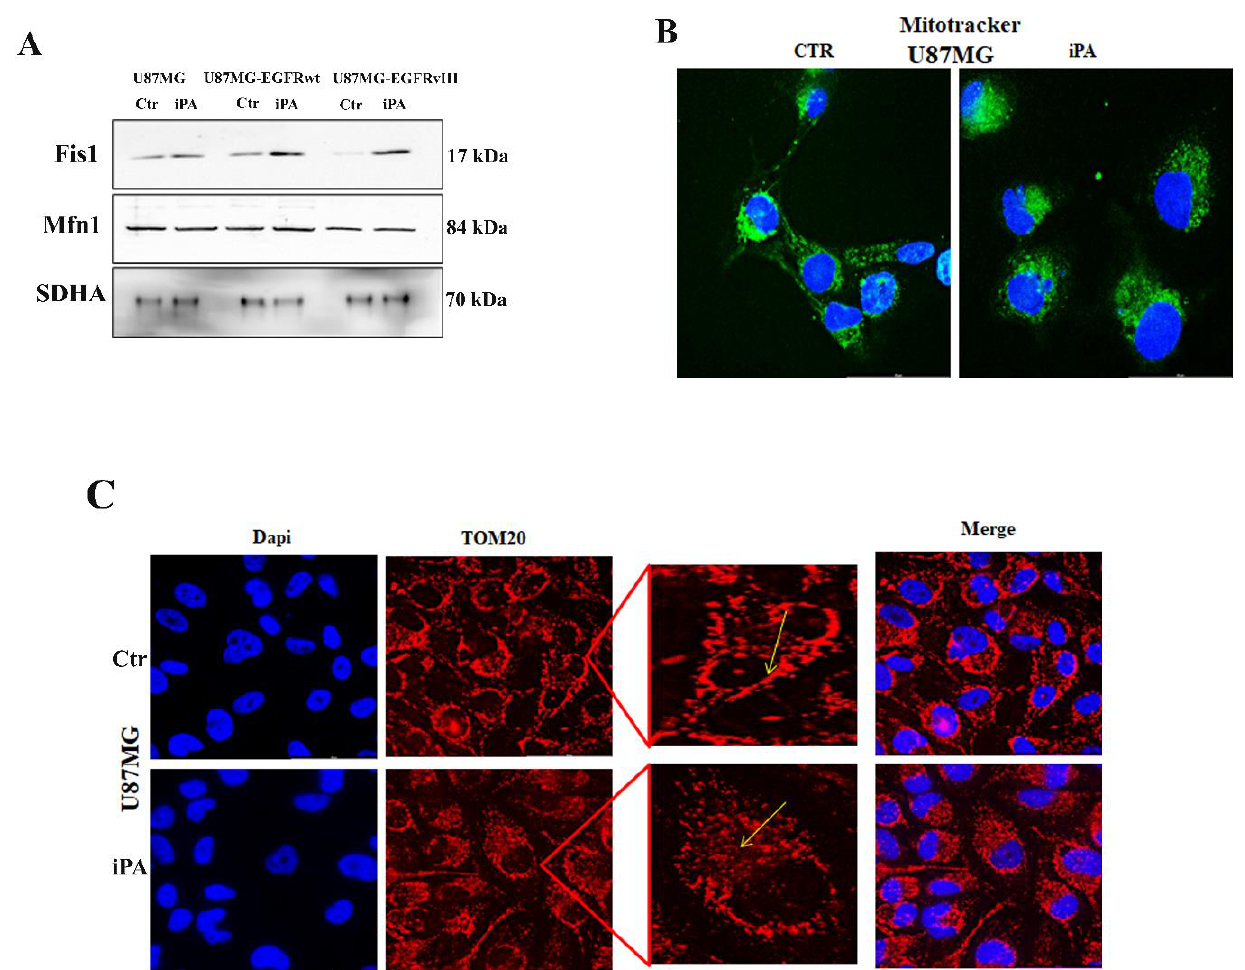
Figure 6. iPA interferes with mitochondrial dynamics. ( A ) Western blot of Fis1 and Mfn1 in U87MG, U87MG-EGFRwt, U87MG-EGFRvIII. ( B ) Mitochondria staining in U87MG cell line using DAPI to stain nuclei and MitoTracker (Green) to stain mitochondria. MitoTracker staining shows that mitochondrial shape was changed by iPA 10 µ M treatment. ( C ) Immunofluorescence analysis of mitochondria using primary antibody TOM20 (red), while the nuclei were stained with DAPI. The images show that U87MG cells treated with iPA 10 µ M (lower panel) contained more round or fragmented mitochondria, while untreated cells (upper panel) contained more fused or elongated mitochondria (mitochondrial morphological changes are indicated by the yellow arrow). Data were analyzed for statistical significance using the 2-tailed Student t -test or ANOVA following by Bonferroni correction for multiple comparisons. Results are representative of 3 experiments performed in duplicate and are expressed as mean ± SD.